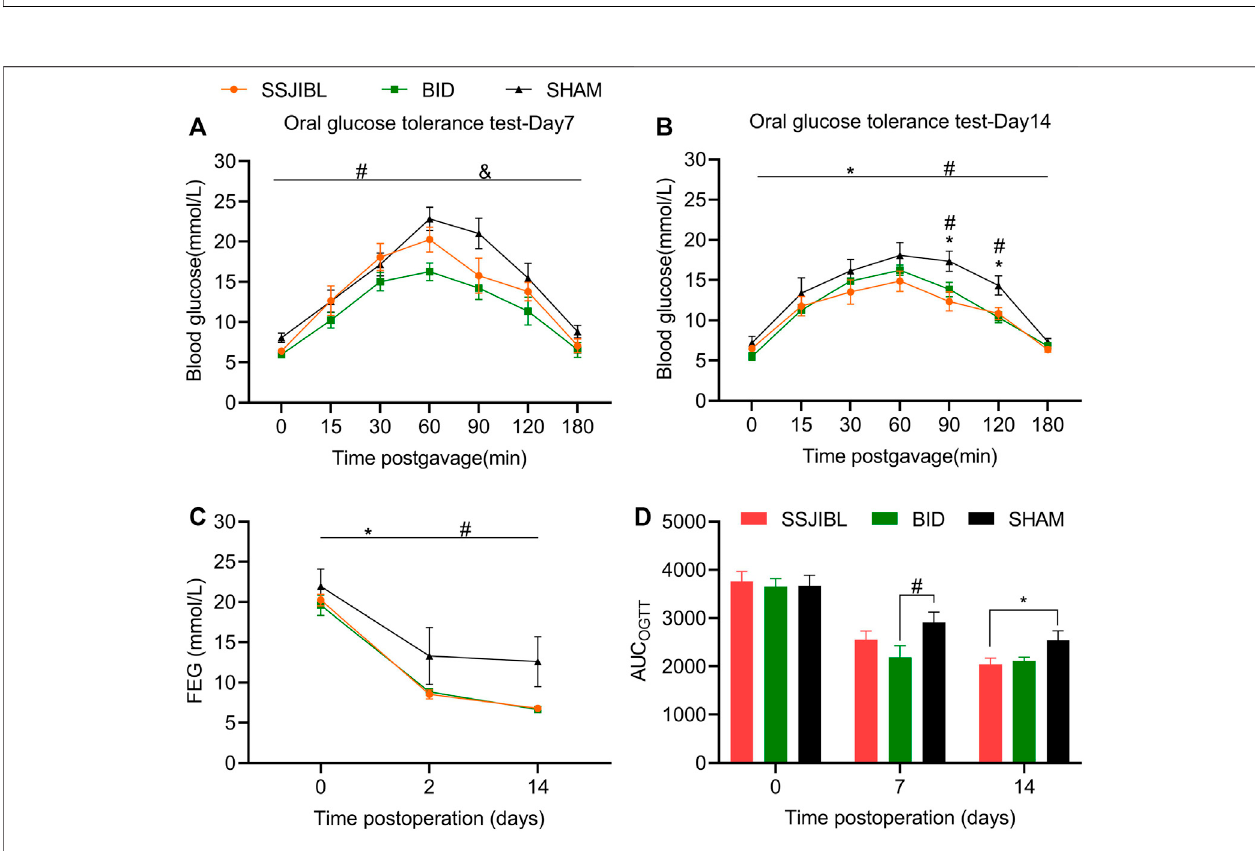
FIGURE 3 | OGTT and FEG. (A) OGTT 7 days after surgery ( n = 6 for SSJIBL, n = 6 for Sham, and n = 6 for BID). All rats were fasted for 12 h and fed with 10% glucose(1 g/kg)intragastrically. (B) OGTT14 daysaftersurgery. (C) AverageFEGlevelsofratsinallgroupsbefore,2and14 daysafterthesurgery. (D) AUC-OGTT.The area under the curve (AUC) was calculated using trapezoidal integration. Fed blood glucose (FEG); Oral glucose tolerance test (OGTT). * p < 0.05 for SSJIBL versus SHAM group; # p < 0.05 for BID versus SHAM group; & p < 0.05 for SSJIBL versus BID.